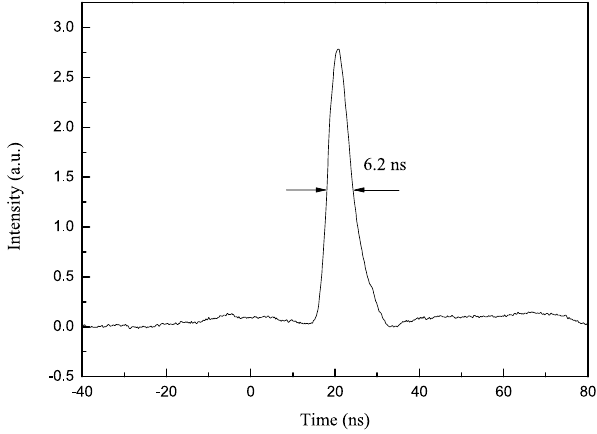
Figure 3. Pulse shape of the novel LN Q-switched Nd:YAG laser.